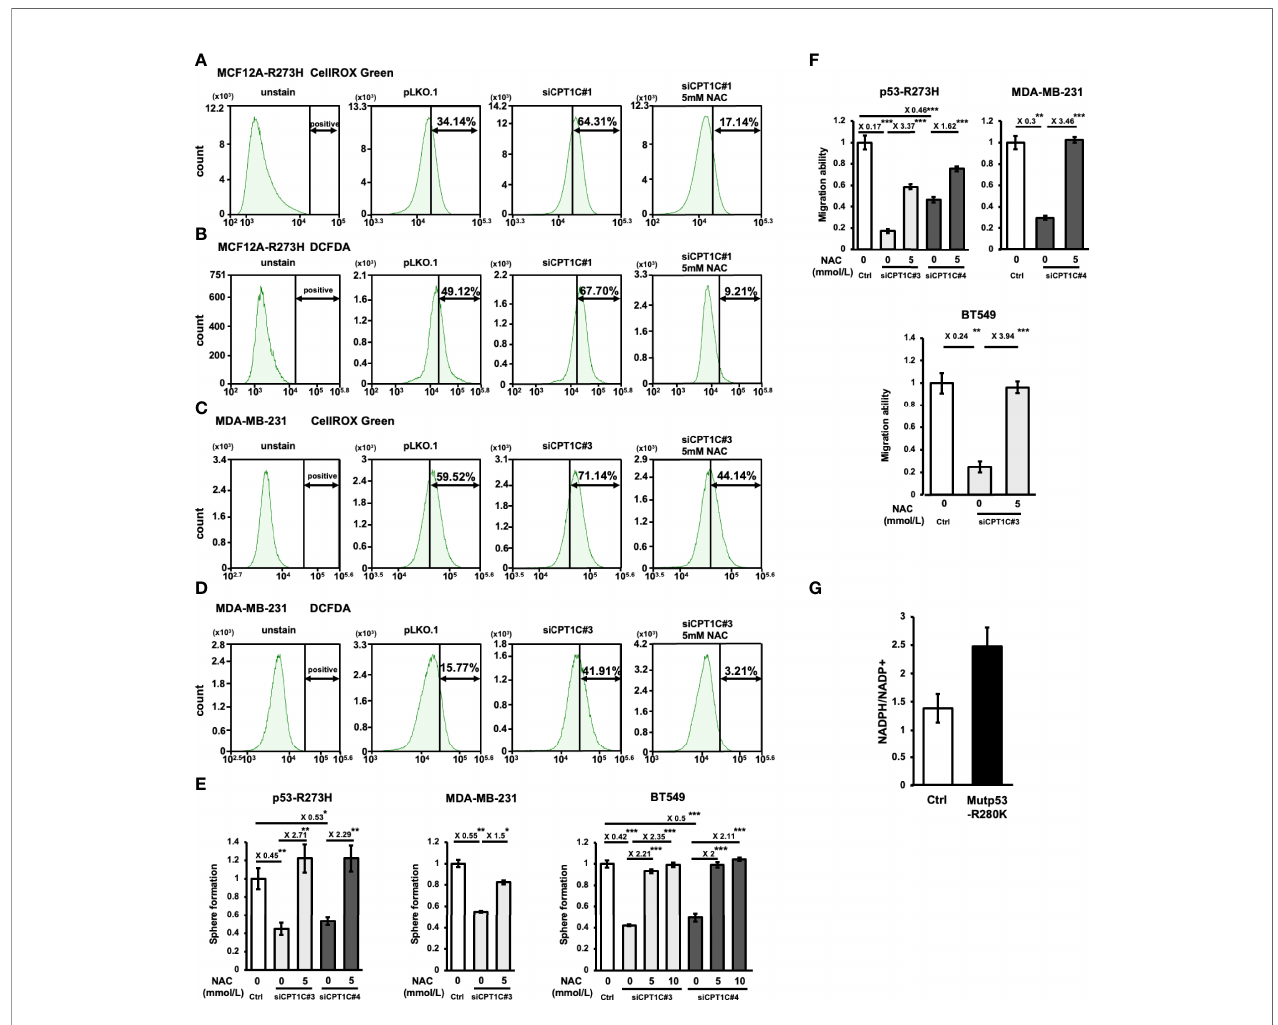
FIGURE 5 | CPT1C regulates mutant p53-mediated biological effects through modulating redox status. (A – D) Total cellular ROS level is elevated by knockdown of CPT1C in MCF12A R273H (A, B) and MDA-MB-231 (C, D) cells and is compromised by N-acetyl cysteine (NAC) treatment. Cells were stained with CellROX ™ Green Reagent (A, C) or DCFDA (B, D) , then the fl uorescence was measured by FACS to determine the total cellular ROS. Similar trends in the representative images were observed in three independent experiments. (E, F) CPT1C de fi ciency-mediated suppression of cancer stemness and migration ability are rescued by NAC treatment. MCF12A R273H [ (E , F) , left], MDA-MB-231 [ (E , F) middle], and BT549 [ (E, F) right] cells treated with NAC (0, 5, or 10 mmol/L) for 1 day and its Ctrl cells were subjected to mammosphere formation assay and transwell migration assay (mean ± SD; n = 3). The two sides of the lines above the bars indicated the comparison of the two groups, and the value offold changes with the asterisks representing signi fi cance was marked above the line. Data were analyzed by unpaired t-test, *p < 0.05, **p < 0.01, ***p < 0.001. (G) The ratio of NADPH/NADP + is upregulated by mutant p53. The absolute amount of NADPH and NADP + were measured by CE-TOFMS and CE-QqQMS analysis, and the ratio of NADPH/NADP + in MCF12A-ctrl and MCF12A-p53 R280K were compared and shown in bar graphs (mean ± SD, n =